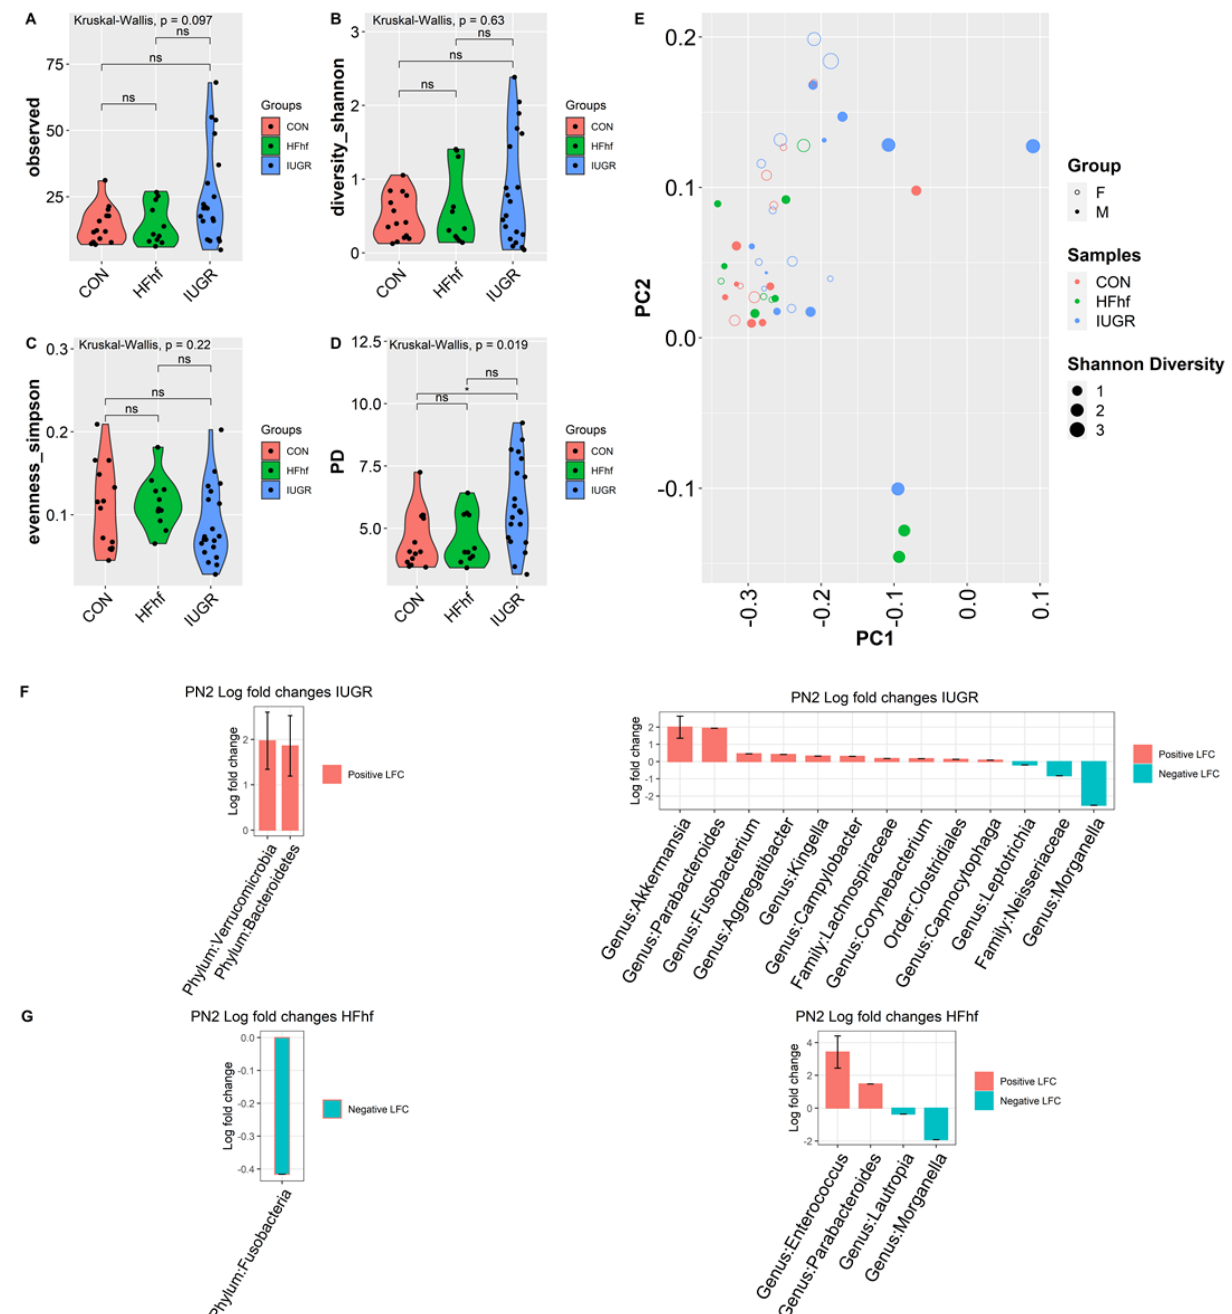
Figure 4. Effects of dietary influences on gut bacterial diversity at PN2: Violin plots showing gut microbiota alpha diversity at postnatal day 2 (PN2) ( A – D ) with four different matrices. Kruskal – Wallis p -values are denoted for each comparison with post hoc Dunn test for comparison between different dietary groups. Significance levels are marked as * p < 0.05. n.s., not statistically significant. ( E ) Principal coordinates analysis of Bray – Curtis distance based on 16S rRNA gene profiling of feces collected from early postnatal stage (PN2) of different dietary groups. ( F , G ) Evaluation of the relative abundance of microbial taxa in different dominant diet categories using differential analysis between IUGR and CON ( F ), and between HFhf and CON ( G ). The bars represent log2 fold change. Only microbial taxa with significant fold changes ( p < 0.05) at the phylum ( left ) and genus ( right ) levels are shown. Members of microbial families that are not classified at the genus level are also included in the right panels.